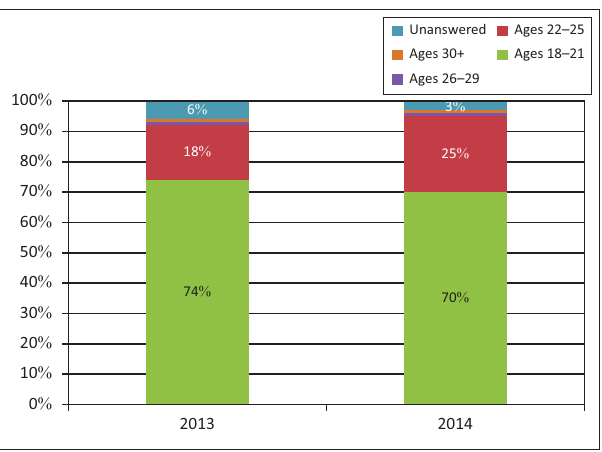
FIGURE 1: Age distribution of samples: 2013 and